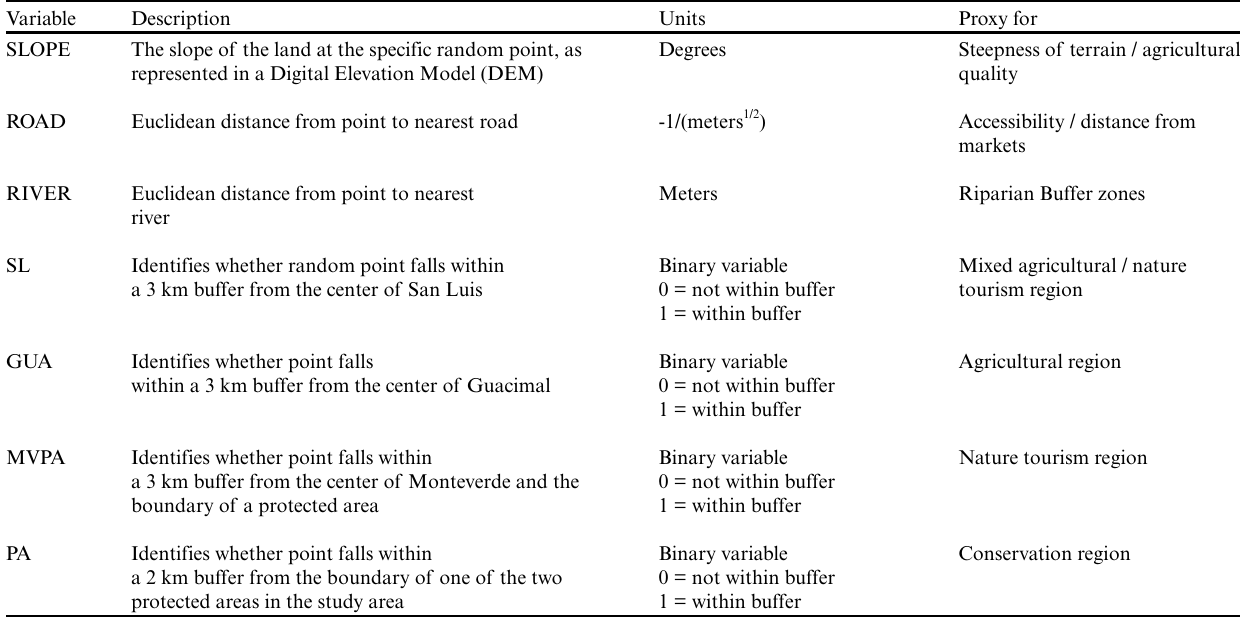
Table 1 . Independent variables used in the logistic regression to explain probability of forest regrowth between 1985-2009. Variable Description Units Proxy for SLOPE Degrees ROAD Euclidean distance from point to nearest road -1/(meters 1/2 )